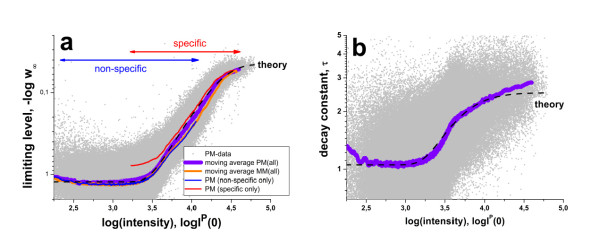
Limiting values (panel a) and decay times (panel b) of the washing function as a function of the initial probe intensity logIP(0): The dots are the probe-level data of all PM-probes of array A (see Eqs. (8) and (9)). The moving average was calculated over 1000 probe-level data to extract the mean effect of intensity on both parameters (thick curves). The moving average of the MM probes (probe-level data are omitted for clarity) is virtually indistinguishable from that of the PM probes. The PM-data are also split into probes which are hybridized predominantly non-specifically and specifically (thin lines, see text). The respective moving averages cover the low-intensity and high intensity ranges, respectively, with considerable overlap (see arrows in panel a). These results show that the washing parameters are mainly determined by the probe intensities and thus by the binding constant independently of the probe type (PM or MM) and of the hybridization mode (specific or non-specific). The mean trends of w∞ and τ are well described using Eqs. (18) and (17) given in the Methods-section (dashed lines). Accordingly, the stepwise change of the washing parameters is governed by their power law dependence on the binding constant. The fits use a critical exponent of γ = 1.6 and the critical intensities of logI(0)crit = 3.8 (for w∞) and 3.5 (for τ). The critical exponent and the critical intensity determine the sharpness of the sigmoidal change and the position of its inflection point, respectively (see also Figure 16 for illustration).